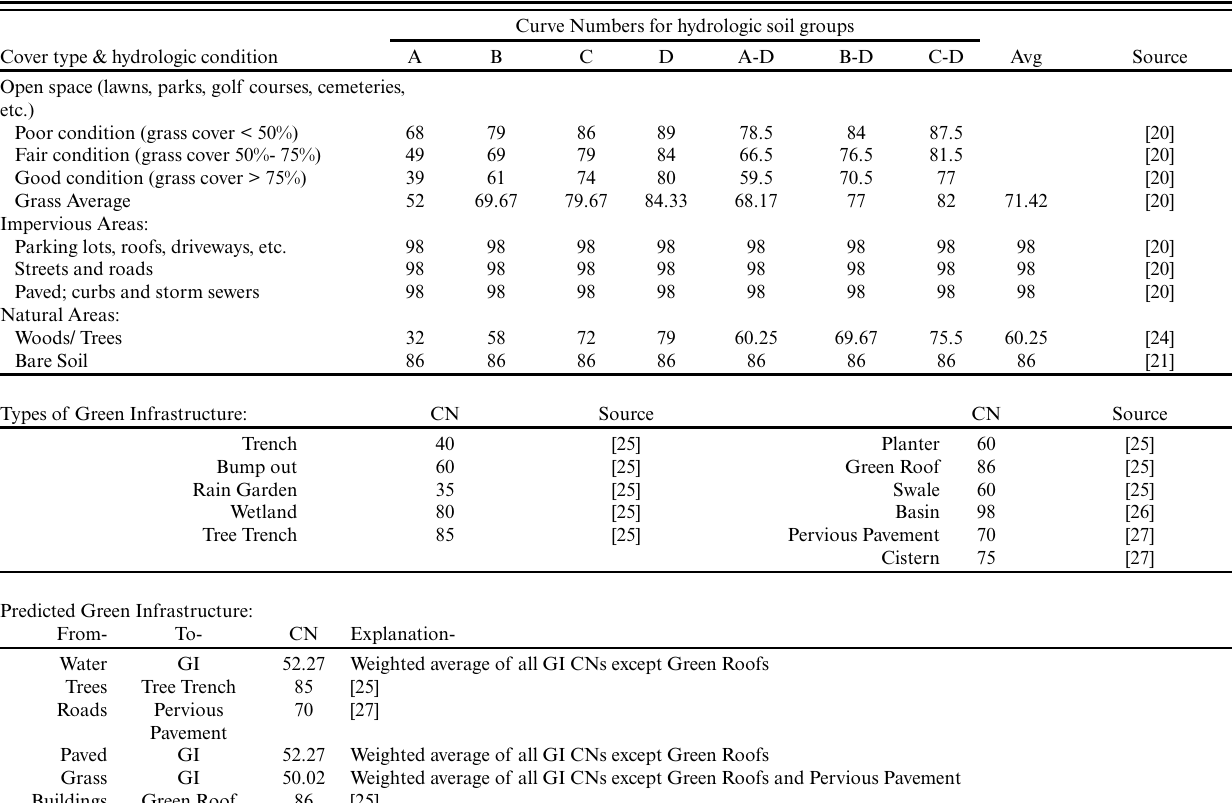
Table 3 . Curve numbers of different land covers and types of green infrastructure. Curve Numbers for hydrologic soil